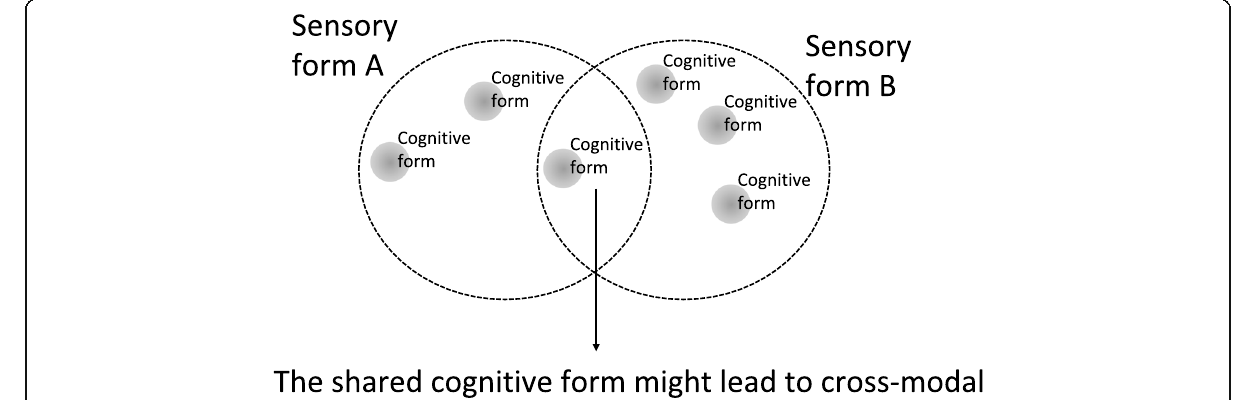
Fig. 2 Diagram to show how cross-modal associations can arise when two sensory forms overlap, in line with the metamodal hypothesis. For example, Sensory form A could be pitch (the perception of auditory frequency) and Sensory form B could be visuospatial elevation. The overlapping space would include forms that are “ high ” such as a high-pitched sound and an object high in elevation (cf. Melara & O ’ Brien,